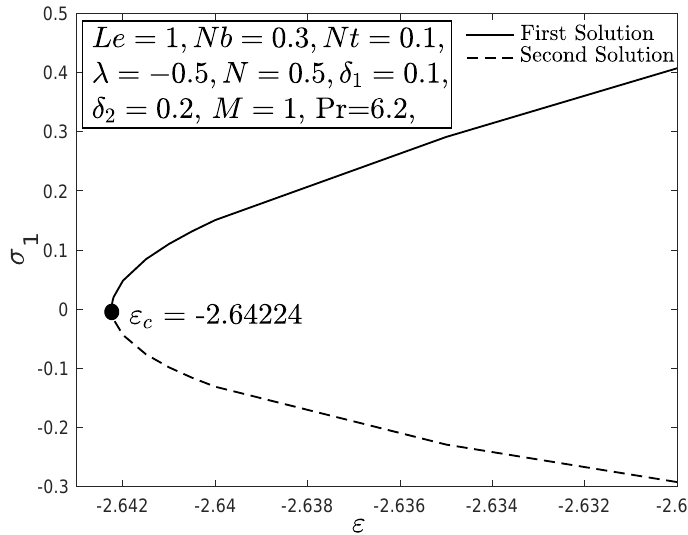
Figure 15. The smallest eigenvalue σ 1 of both first and second solutions towards ε with S =